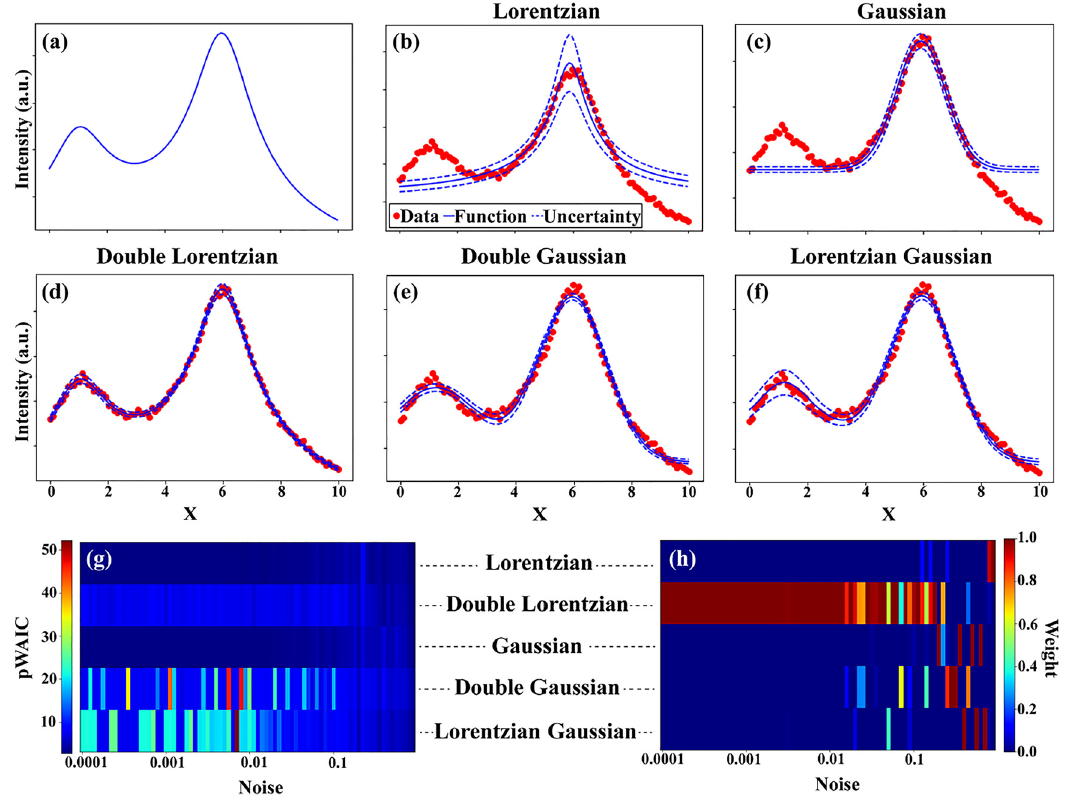
Figure 5: Shown in (a) is the Double Lorentzian function (known truth) utilized for the synthetic dataset. The fi t and uncertainty for the (b) Lorentzian, (c) Gaussian, (d) Double Lorentzian, (e) Double Gaussian, and (f) Lorentzian-Gaussian models are shown. Shown in (g) is how the WAIC parameters changes for each model as a function of noise.Similarly, (h) shows how the weightparameters changes for each model as a function of